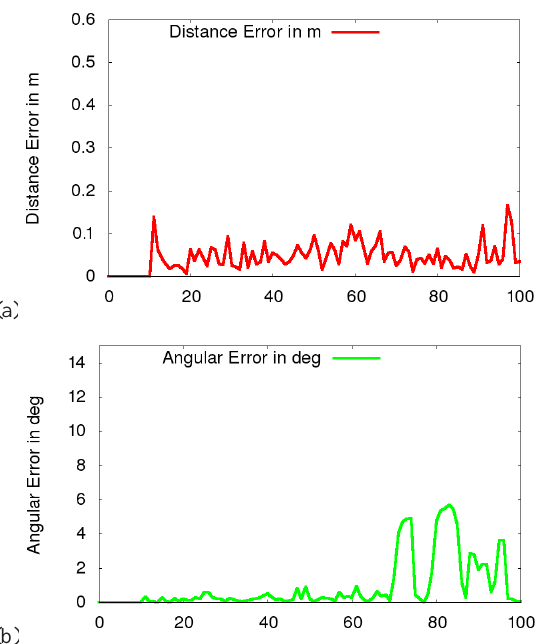
Figure 10: Translational (a) and rotational (b) errors of laser- based trajectory (100 3D scans) compared to MoCap